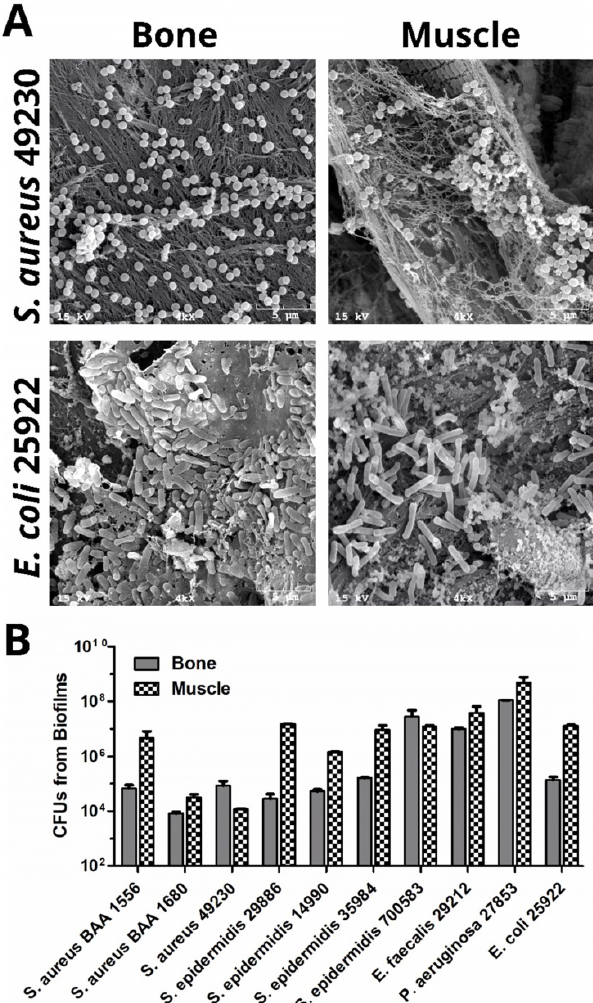
Figure 1. Biofilm characterization. (A) SEM analysis and (B) CFU counts following 72 hr biofilm growth on bone and muscle tissue. SEM images were taken at 4000X magnification and show two representative biofilm strains (all additional strains in Supplemental Figures S1 and S2). CFUs are presented as mean values ± standard